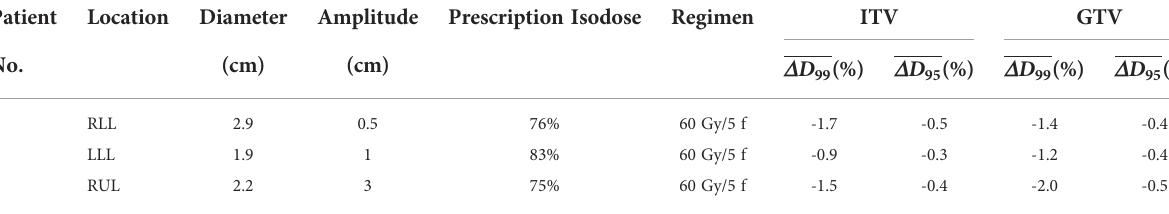
TABLE 1 Tumor characteristics and dose differences for the ITV and GTV analyses of the three patients. Patient